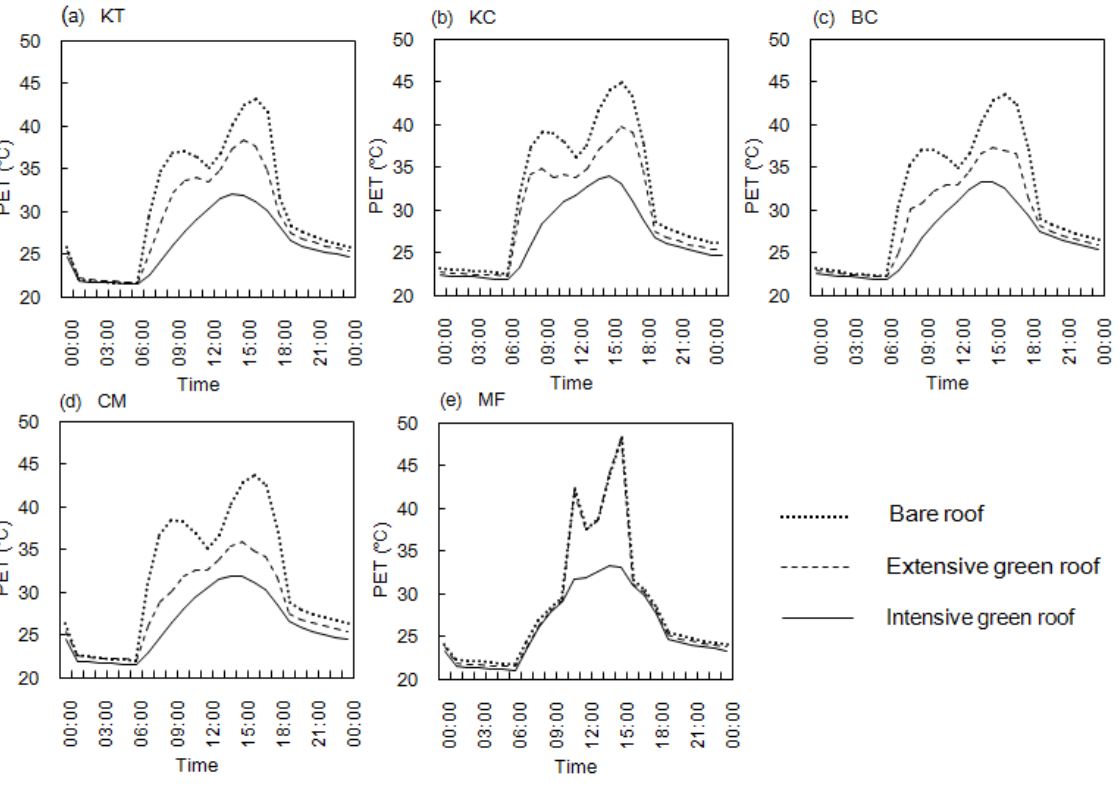
Figure 10. Diurnal PET circle under the three scenarios of bare roof, EGR and IGR at the rooftop-podium